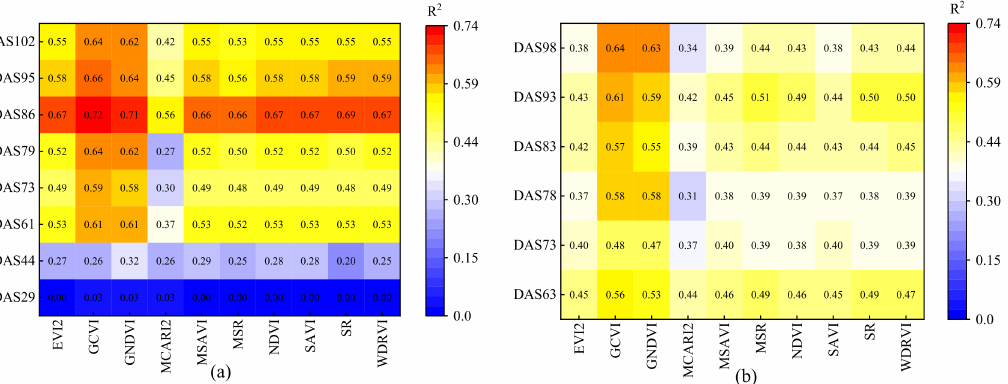
Figure 2. Coefficient of determination (R 2 ) between VIs and corn yield at different growth stages based on ( a ) PlanetScope images and ( b ) Sentinel-2